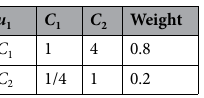
Table 3. Coating service life judgment matrix.